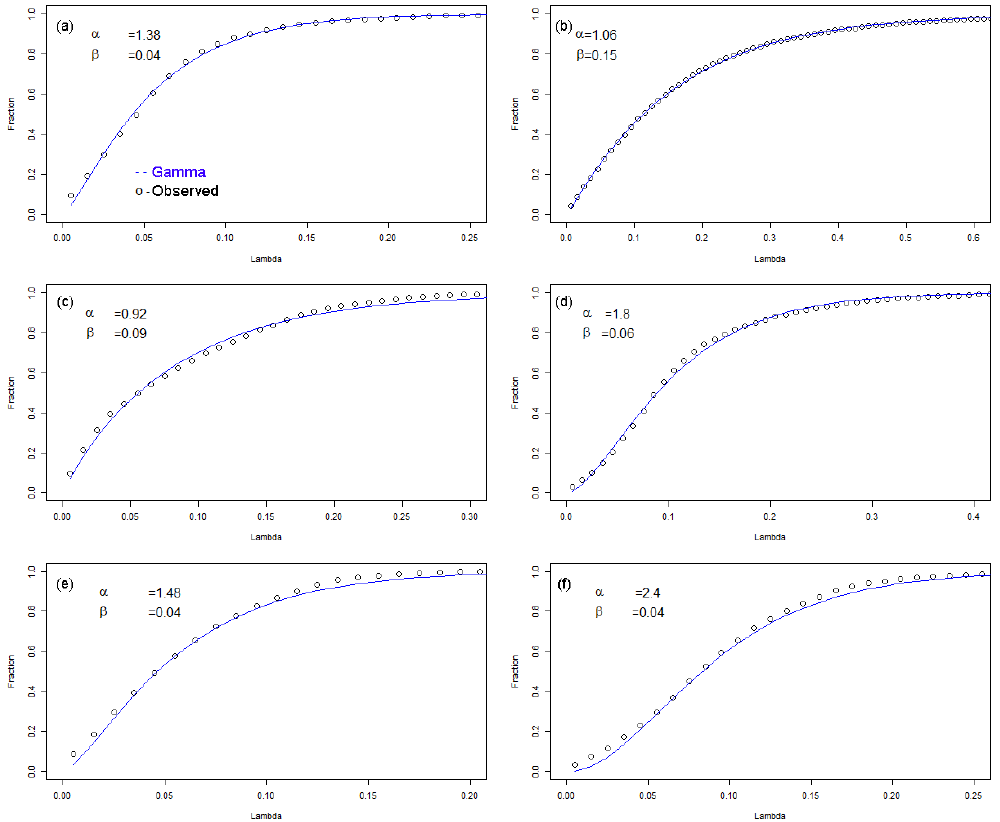
Figure 3. Empirical and fitted (gamma, blue line) CDFs of (cid:51) for six Norwegian catchments. (cid:51) is sampled using Eq. (3) for all observed recession